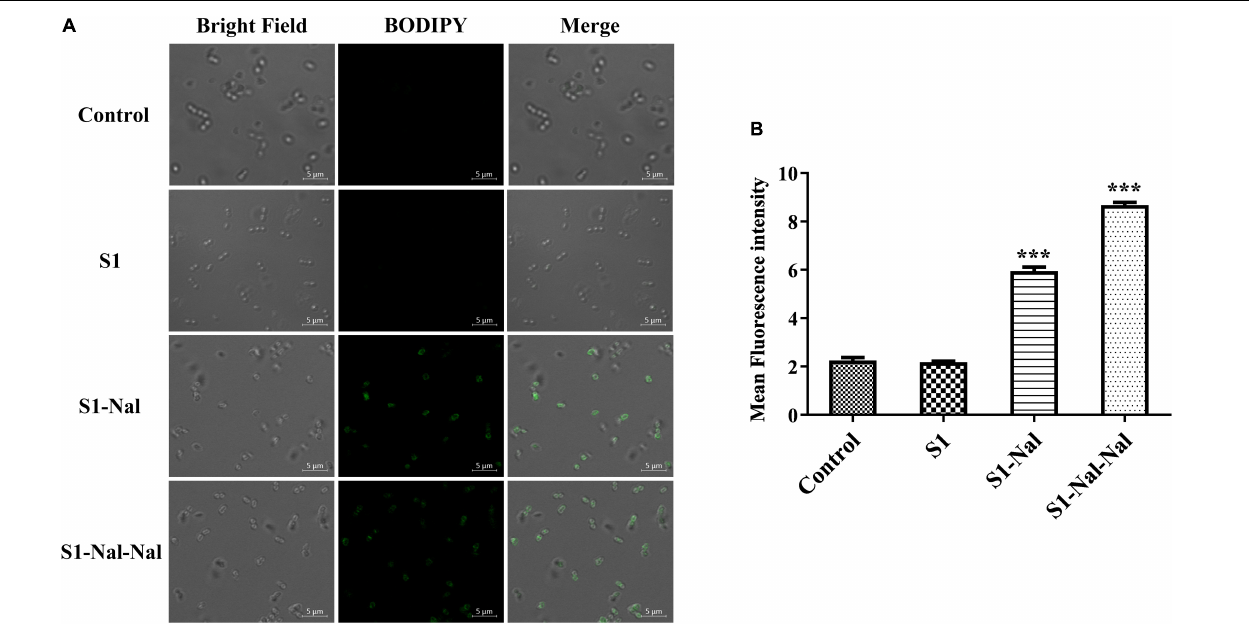
FIGURE 2 | S-Nal and S1-Nal-Nal increase the uptake of boron-dipyrro-methene (BODIPY)-labeled vancomycin in E. faecium . (A) Fluorescence images of 10 7 CFU/ml E. faecium BCRC 15B0132 treated with 0.5 × MIC of S1, S1-Nal and S1-Nal-Nal at 37 ◦ C for 30 min, then treated BODIPY-labeled vancomycin for 30 min (scale bar represents 5 µ m). (B) Mean fluorescence intensity of S1, S1-Nal, and S1-Nal-Nal treated in E. faecium BCRC 15B0132. Samples treated with BODIPY-labeled vancomycin only served as a control. Results are presented as means ± SEM, *** P < 0.001 compared with control. n.s., no significant differences.